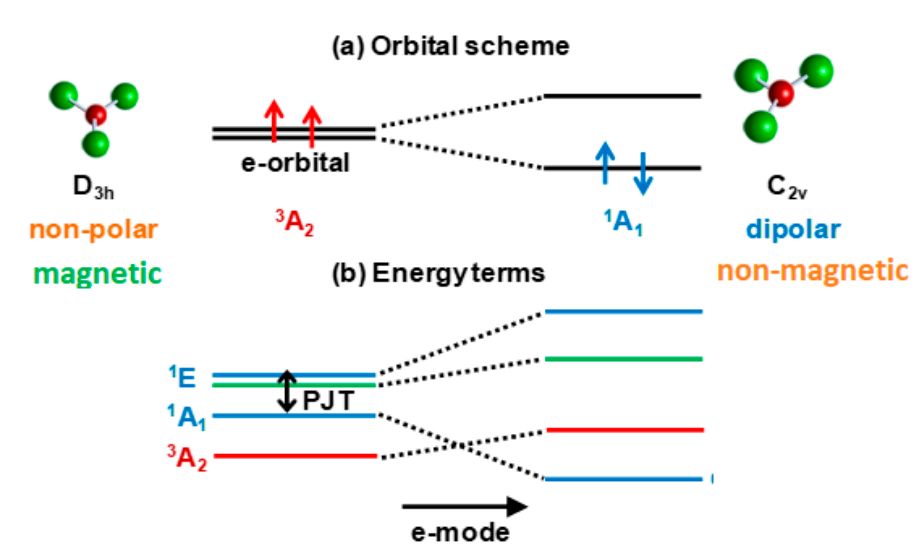
Figure 3. Illustration to the formation of two coexisting configurations with di ff erent magnetic and structural properties: ( a ) In a typical orbital energy level scheme of the electronic e 2 configuration the ground state 3 A 2 is formed by the two electrons with parallel spins, each of them occupying one e orbital, resulting in the e θ ↑ e ε ↑ configuration, which is totally symmetric but magnetic (the spin S = 1); the picture shows the example of a planar triangular molecule (e.g.,CuF 3 ); ( b ) In the energy terms scheme of the same electronic e 2 configuration the first excited singlet state 1 A 1 with the electron configuration (1/ √ 2)(e θ ↑ e θ ↓ + e ε ↑ e ε ↓ ) is totally symmetric too, but due to the PJT interaction with the higher 1 E 1 state it undergoes the orbital disproportionation resulting in either e θ ↑ e θ ↓ or e ε ↑ e ε ↓ configurations, both having a lower symmetry of charge distribution that distorts the systems in the e mode direction, but a zero spin state.